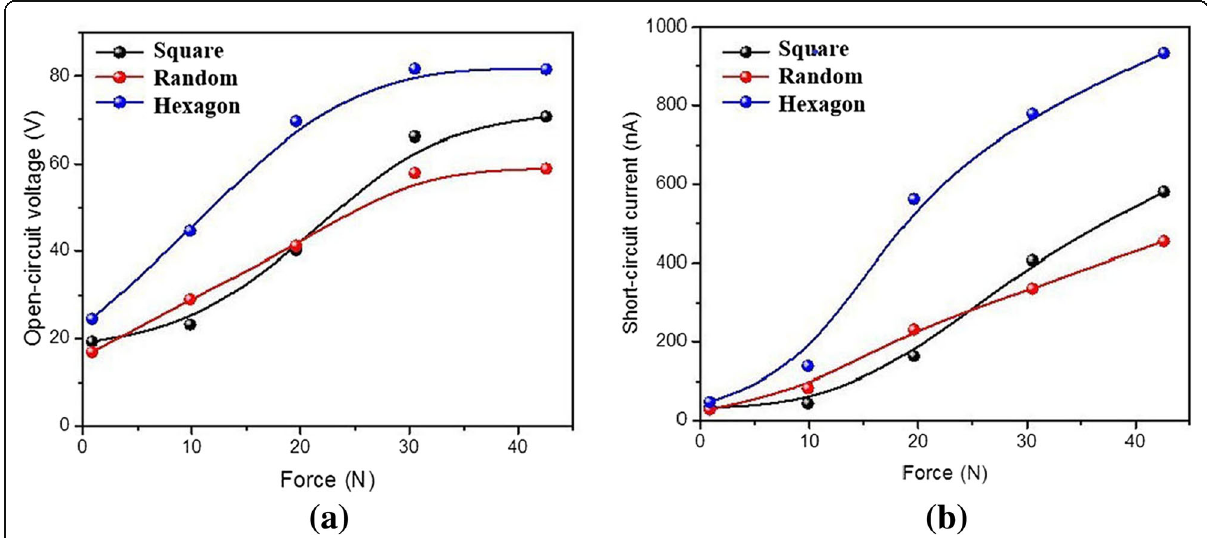
Fig. 6 The electrical properties for three kinds of nanopillar arrays, such as open-circuit voltage ( a ) and short-circuit current ( b